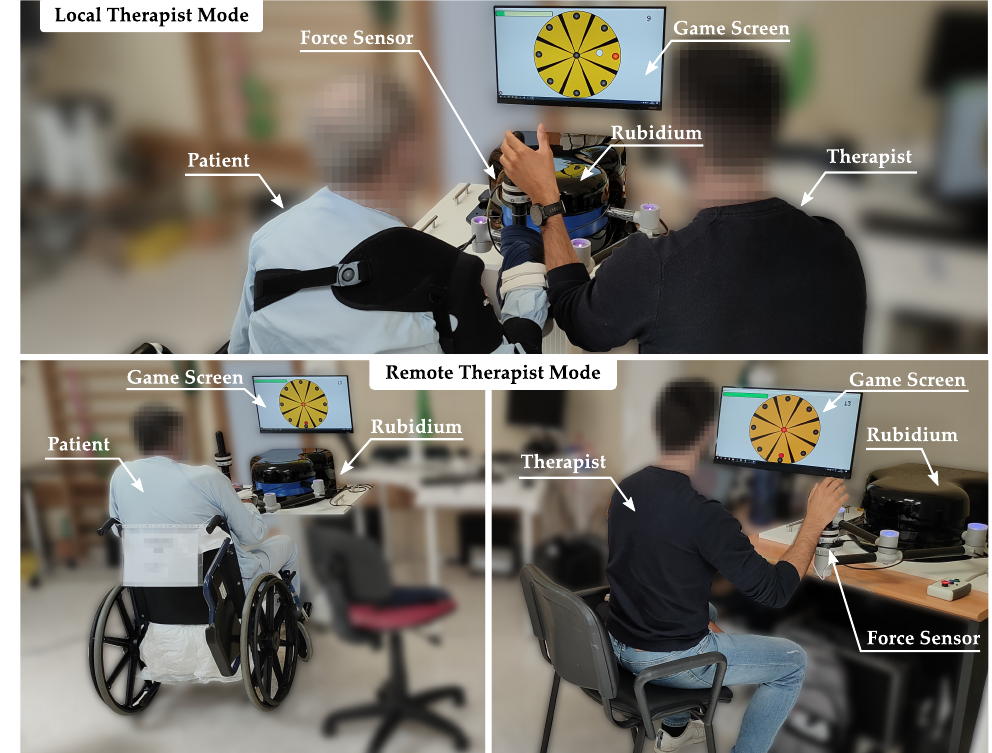
Figure 5. Image of the experimental setup taken during the local and the remote therapist assis- tance